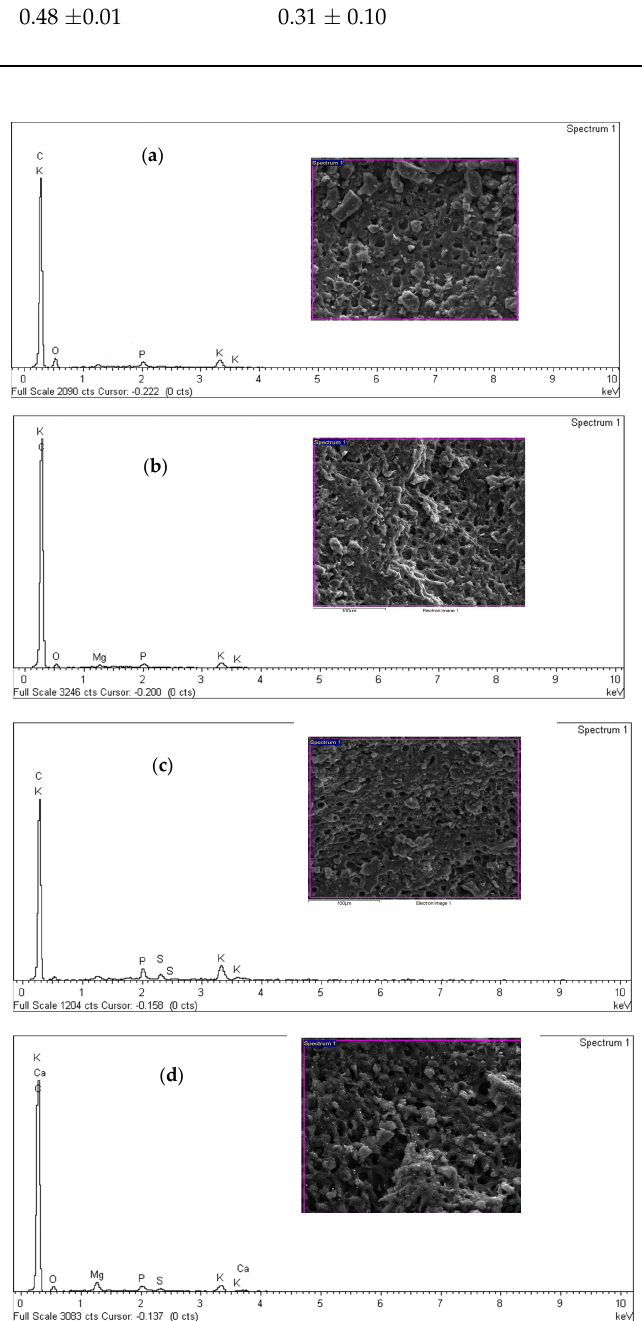
Figure 2. EDX micrograph of the valorized date seed at ( a ) 400 °C ( b ) 600 °C ( c ) 800 °C, and ( d ) 1000 °C.